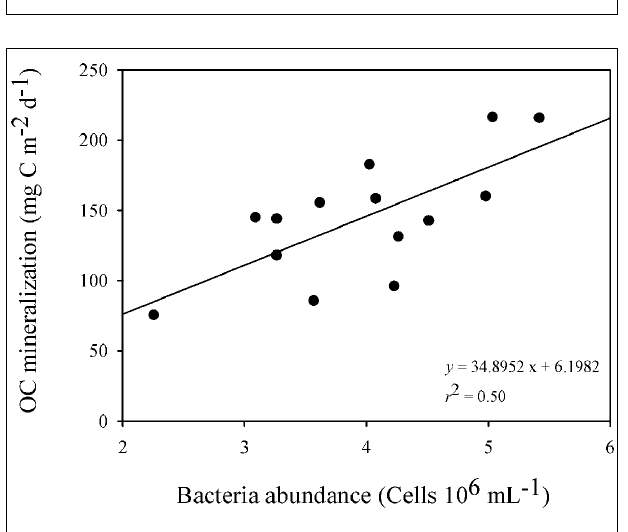
FIGURE 4 | Linear regression describing the relationship between OC mineralization rates in the sediment and the partial pressure of